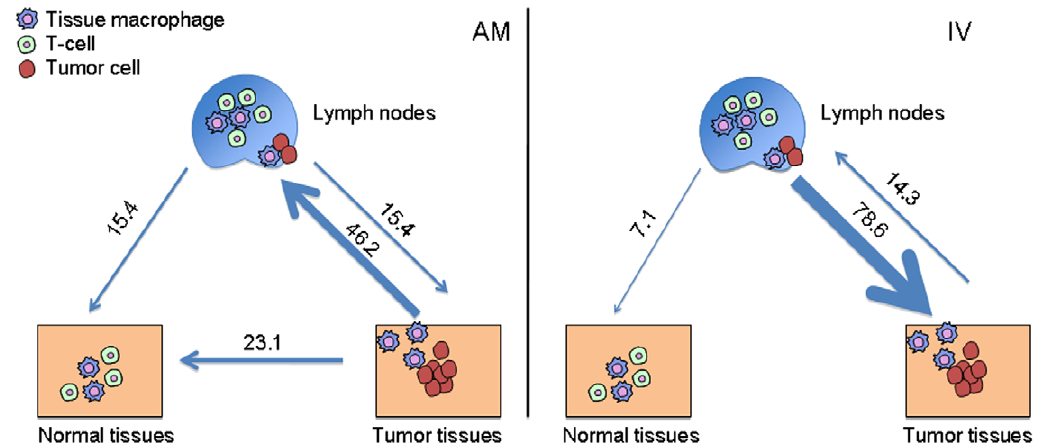
Figure 4. Viral gene flow analysis among different. Light blue arrows represent HIV-1 gene flow from/to normal tissues, tumor tissues and lymph nodes. Viral gene flow among different tissues was inferred with a modified version of the Slatkin and Maddison method 13,28 from the HIV-1 genealogies including strains from different tissues. Numbers on the arrows represent percentage of observed migration in the genealogies. Left panel. Subject AM. Right panel. Subject IV.